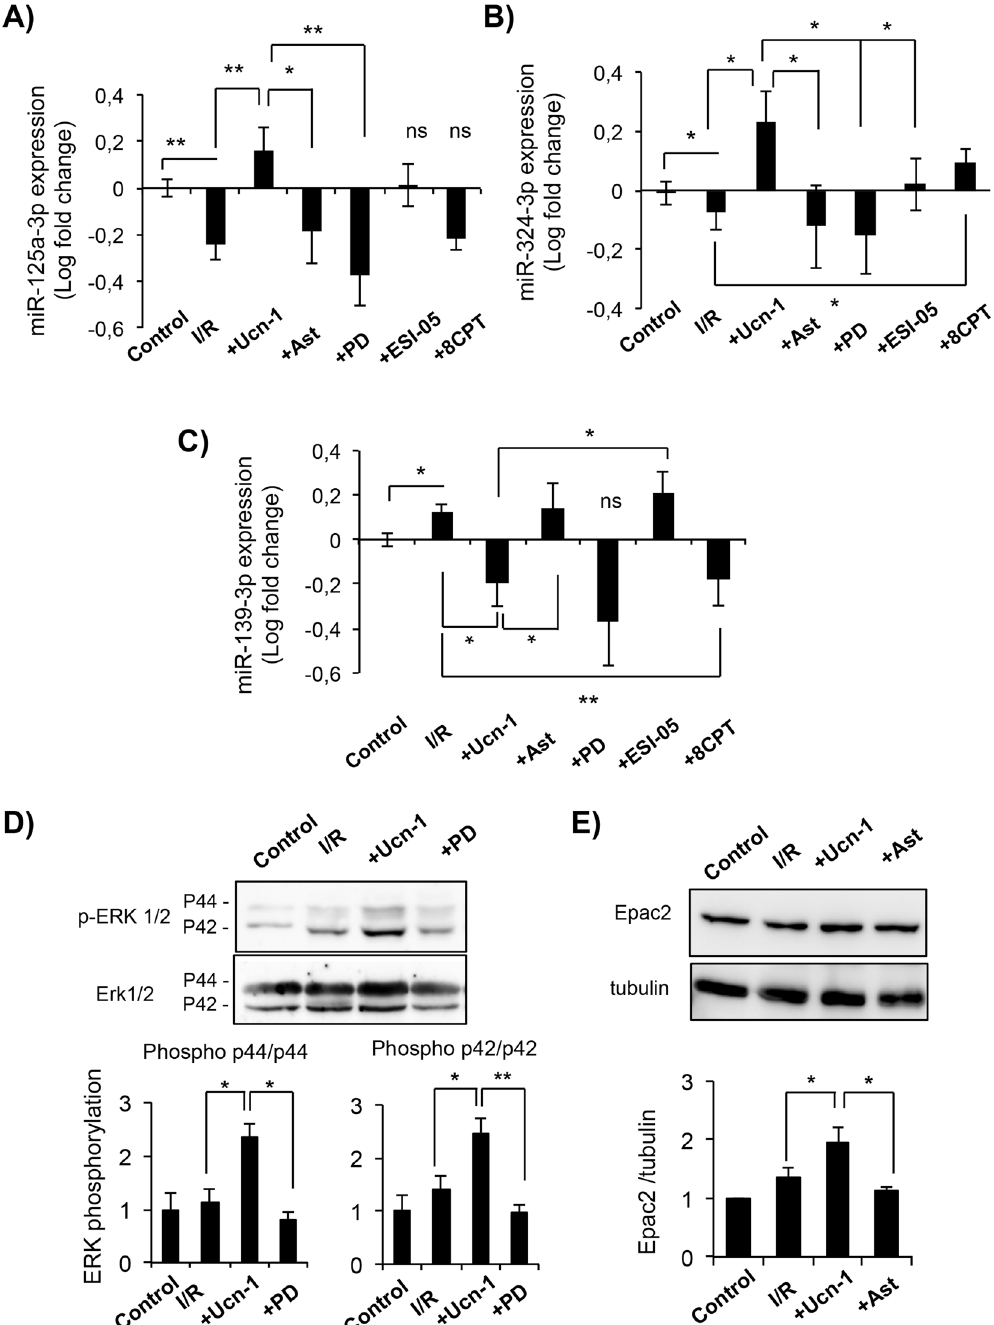
Figure 4. Urocortin-1 regulates the expression of miRNAs in isolated cardiac myocytes through ERK1/2 and Epac2 activation. ( A – C ) Bar graphs show changes in the expression of miR-125a-3p ( A ), miR-324-3p ( B ) and miR-139-3p (C) in isolated cardiac myocytes treated with Ucn-1 (10 nM) in reperfusion. ( D ) Western blot and summary data showing ERK 1/2 phosphorylation in cells exposed to I/R (30 minutes/10 minutes). ( E ) Western blot and summary data showing Epac2 examined in cells exposed to I/R (30 minutes/18 hours each). “I/R” is for cells undergoing I/R protocols. “ + Ast” is for cells subjected to I/R pre-treated 10 minutes with 0.5 µ M astressin to inhibit CRF-R2 before the addition of Ucn-1. “ + PD” is for cells pre-treated 10 minutes with 5 µ M PD 098059 to inhibit ERK1/2, before the addition of Ucn-1. “ + ESI-05” is for cells pretreated 10 minutes with ESI-05 (10 µ M) to inhibit Epac2, before the addition of Ucn-1. “ + 8CPT” is for cells treated with 10 µ M 8CPT at the onset of reperfusion. Values are shown in logarithmic scale and are means ± S.E.M, (n = 6–9 independent cells preparation). “ * ” and “ ** ” indicate significance at p < 0.05 and p <